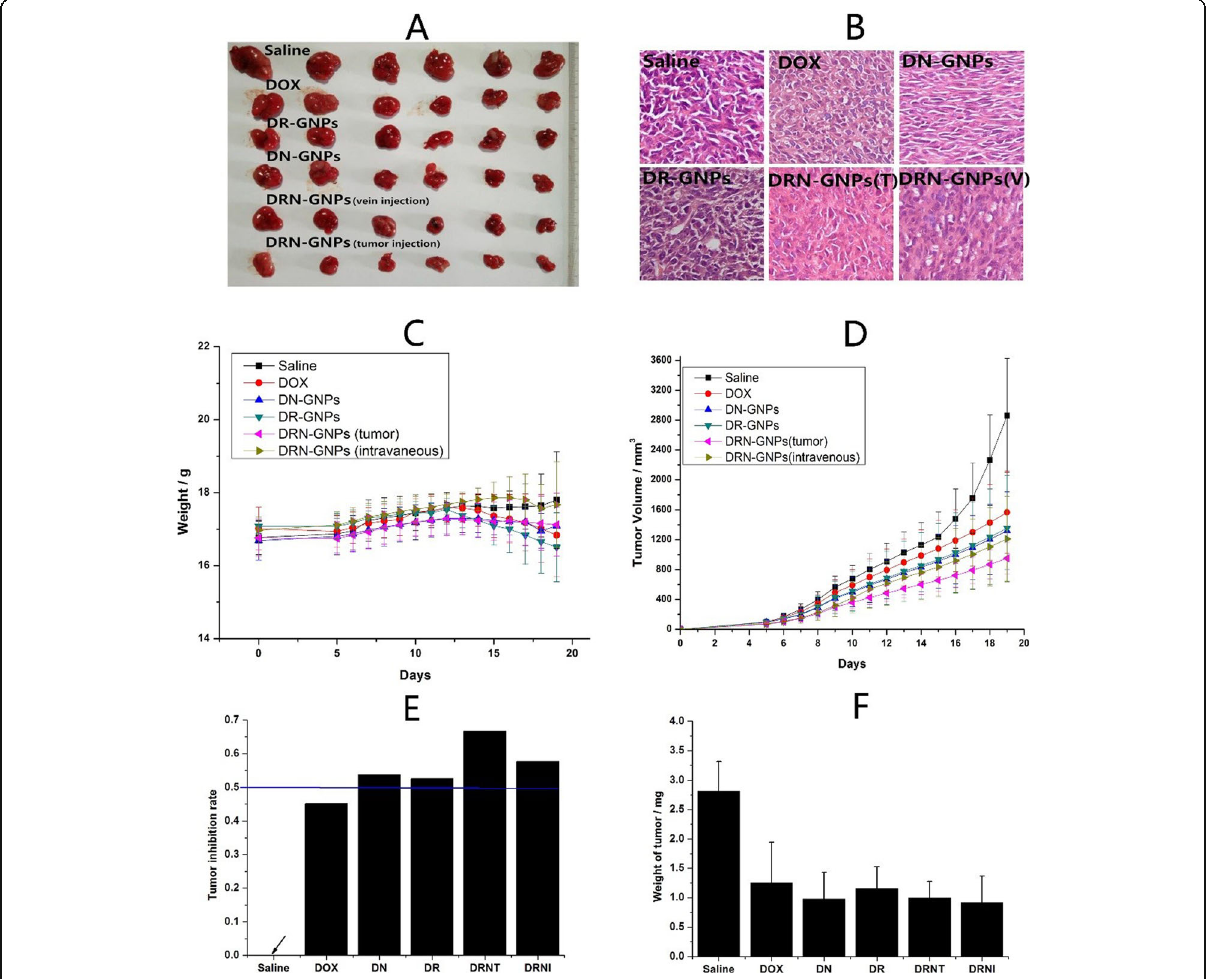
Fig. 8 a Tumor images isolated from tumor-bearing mice after treatment of saline, free DOX, DN-GNPs, DR-GNPs, and DRN-GNPs (tumor injection and intravenous injection). b The histological images of tumors of the mice after treated with saline, free DOX, DN-GNPs, DR-GNPs, and DRN- GNPs (tumor injection and intravenous injection). c Body weight, tumor volume ( d ), tumor inhabitation rate ( e ), and tumor ’ s weight ( f ) of tumor- bearing mice during 14 days treatment; data are represented as means ± standard deviations ( n =